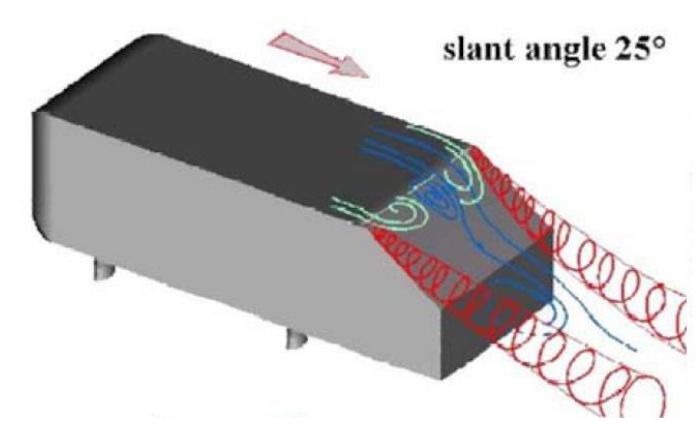
Figure 2. The experimental flow visualization on the slant [7].